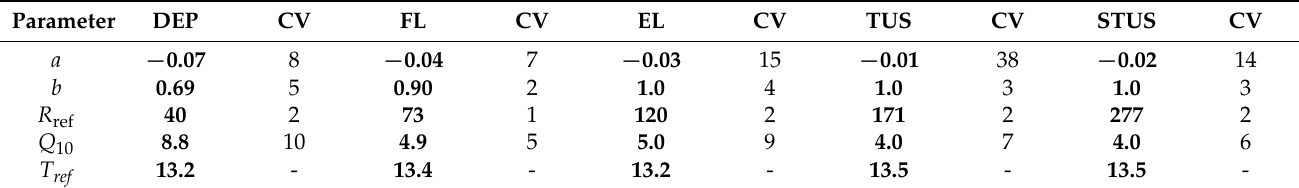
Table 2. Results of parameterization of the soil respiration model. The dependence on soil temperature is described by parameters R ref , Q 10, and T ref ; the dependence on groundwater level by parameters a and b . CVs are the coefficients of variation of fluxes obtained with artificially introduced CV =15% of measured fluxes.